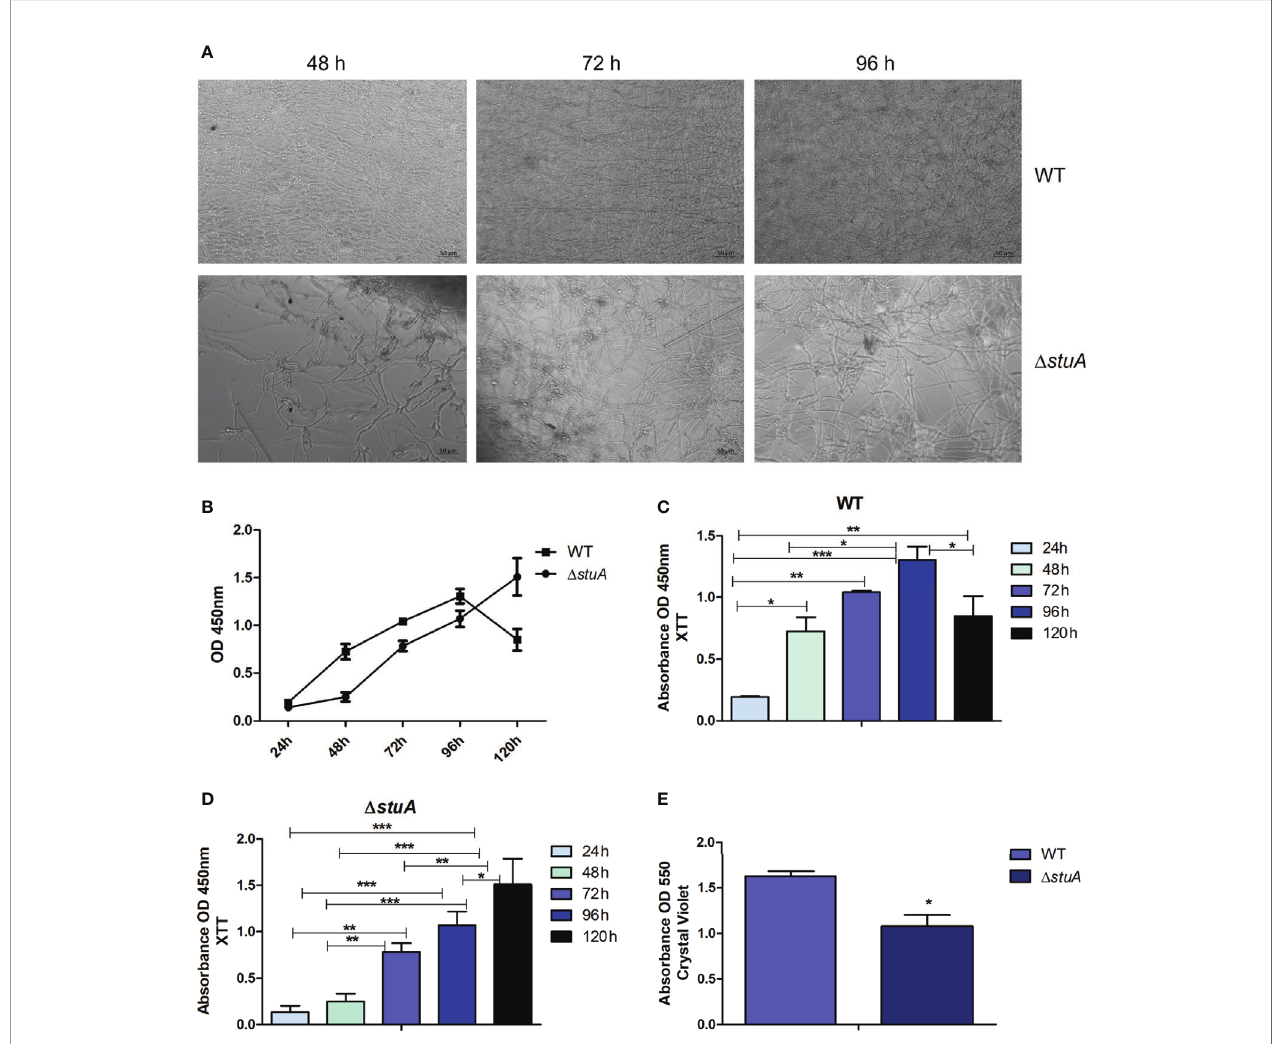
FIGURE 4 | StuA supports cell-cell adhesion. (A) Morphology and (B) comparative kinetics of bio fi lm formation in D stuA and wild-type strains of T. rubrum. Metabolic activity of the bio fi lm produced by (C) wild-type and (D) D stuA strains of T. rubrum at each time point. Statistical signi fi cance was determined using ANOVA followed by Tukey ’ s post-hoc test (* P < 0.05; ** P < 0.01; *** P < 0.001). (E) Biomass production in D stuA and wild-type strains of T. rubrum determined at 96 h by crystal violet staining. Statistical signi fi cance was determined by unpaired T-test (* P <